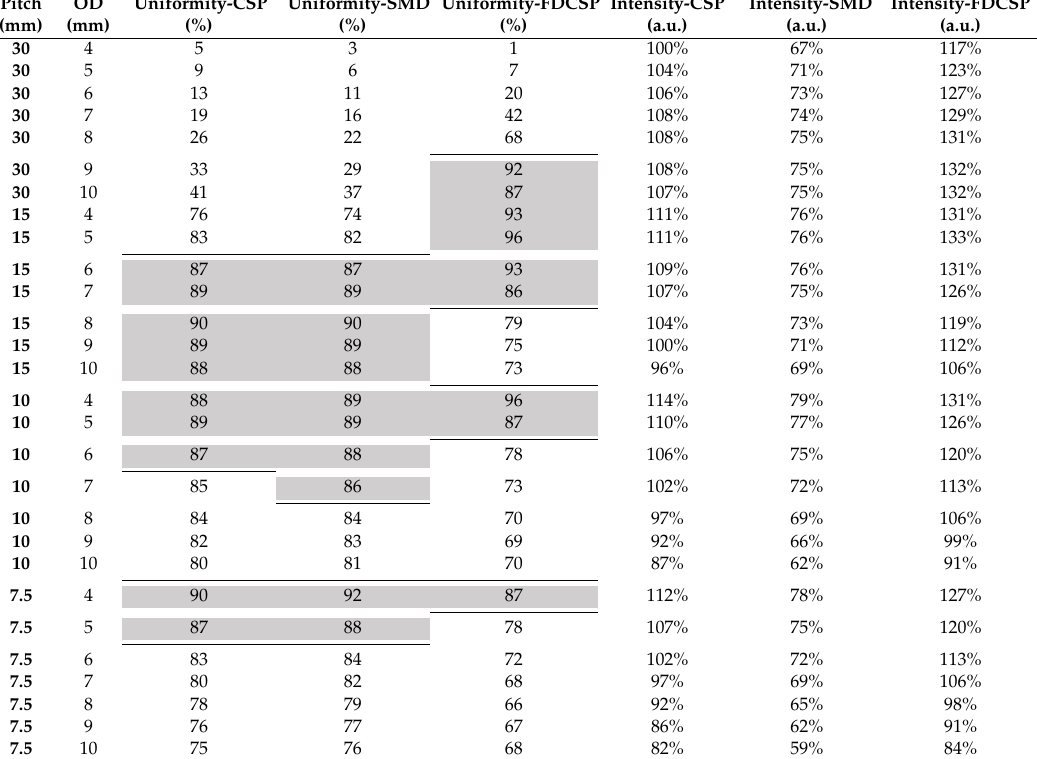
Table 1. Module modeling result. The numbers in the frame means that the uniformity of modulus is over